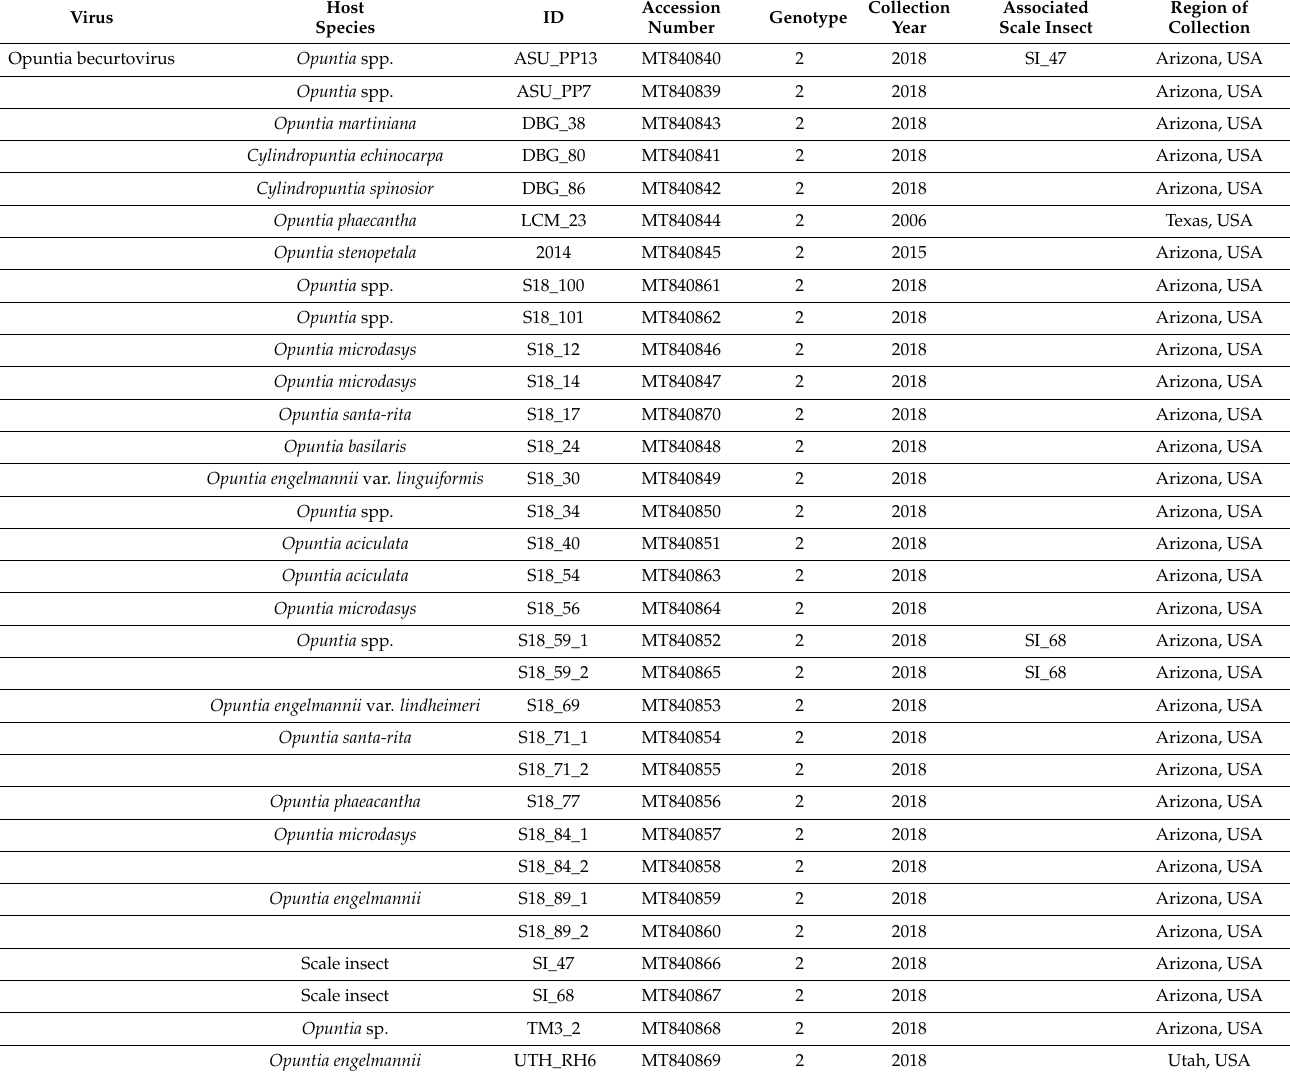
Table 1. Summary of the Opuntia virus 2 and Opuntia becurtoviruses identified in this study with isolate names, accession numbers, genotypes, host species, collection dates, and locations. The instances where the cochineal insect was associated with any cactus host species are